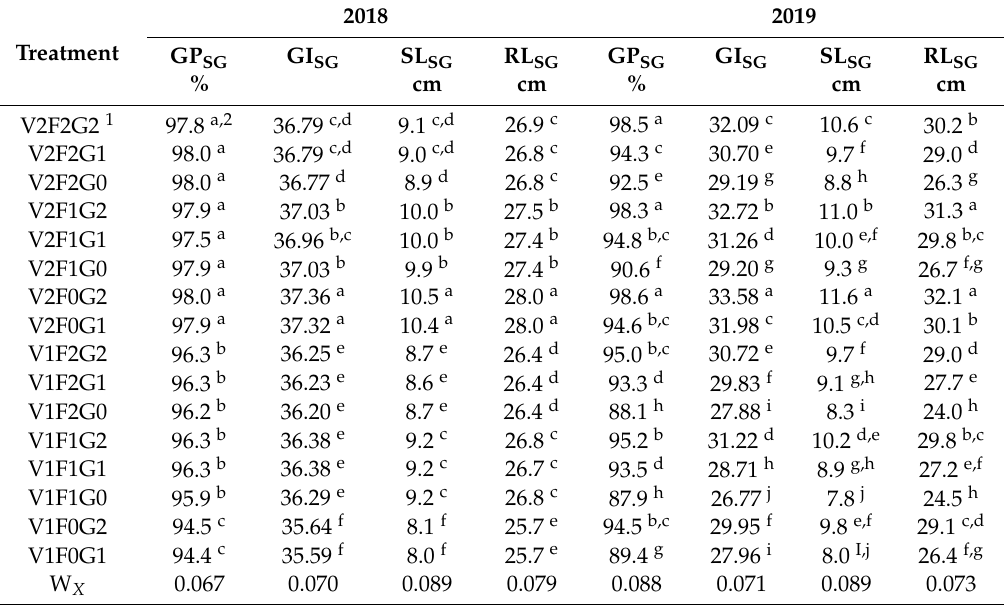
Table 5. Germination percentage (GP), germination index (GI), seedling length (SL), and root length (RL) on the 7th day of standard germination (SG) test under di ff erent irrigation treatments and weight determined using the entropy weight method (W X ) in 2018 and